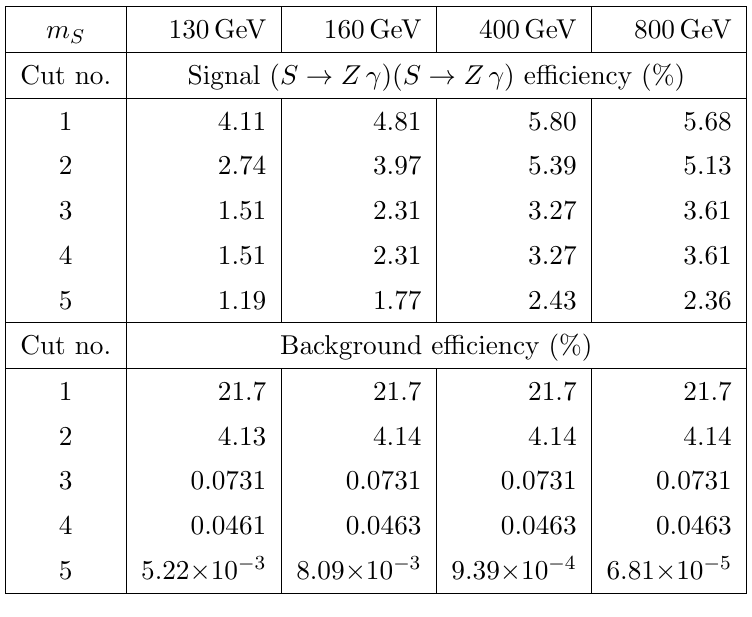
Table 5 . Signal and background e(cid:14)ciencies in percent following the cuts listed in table 4, for the Z (cid:13) SR and m t 0 = 1000 GeV.